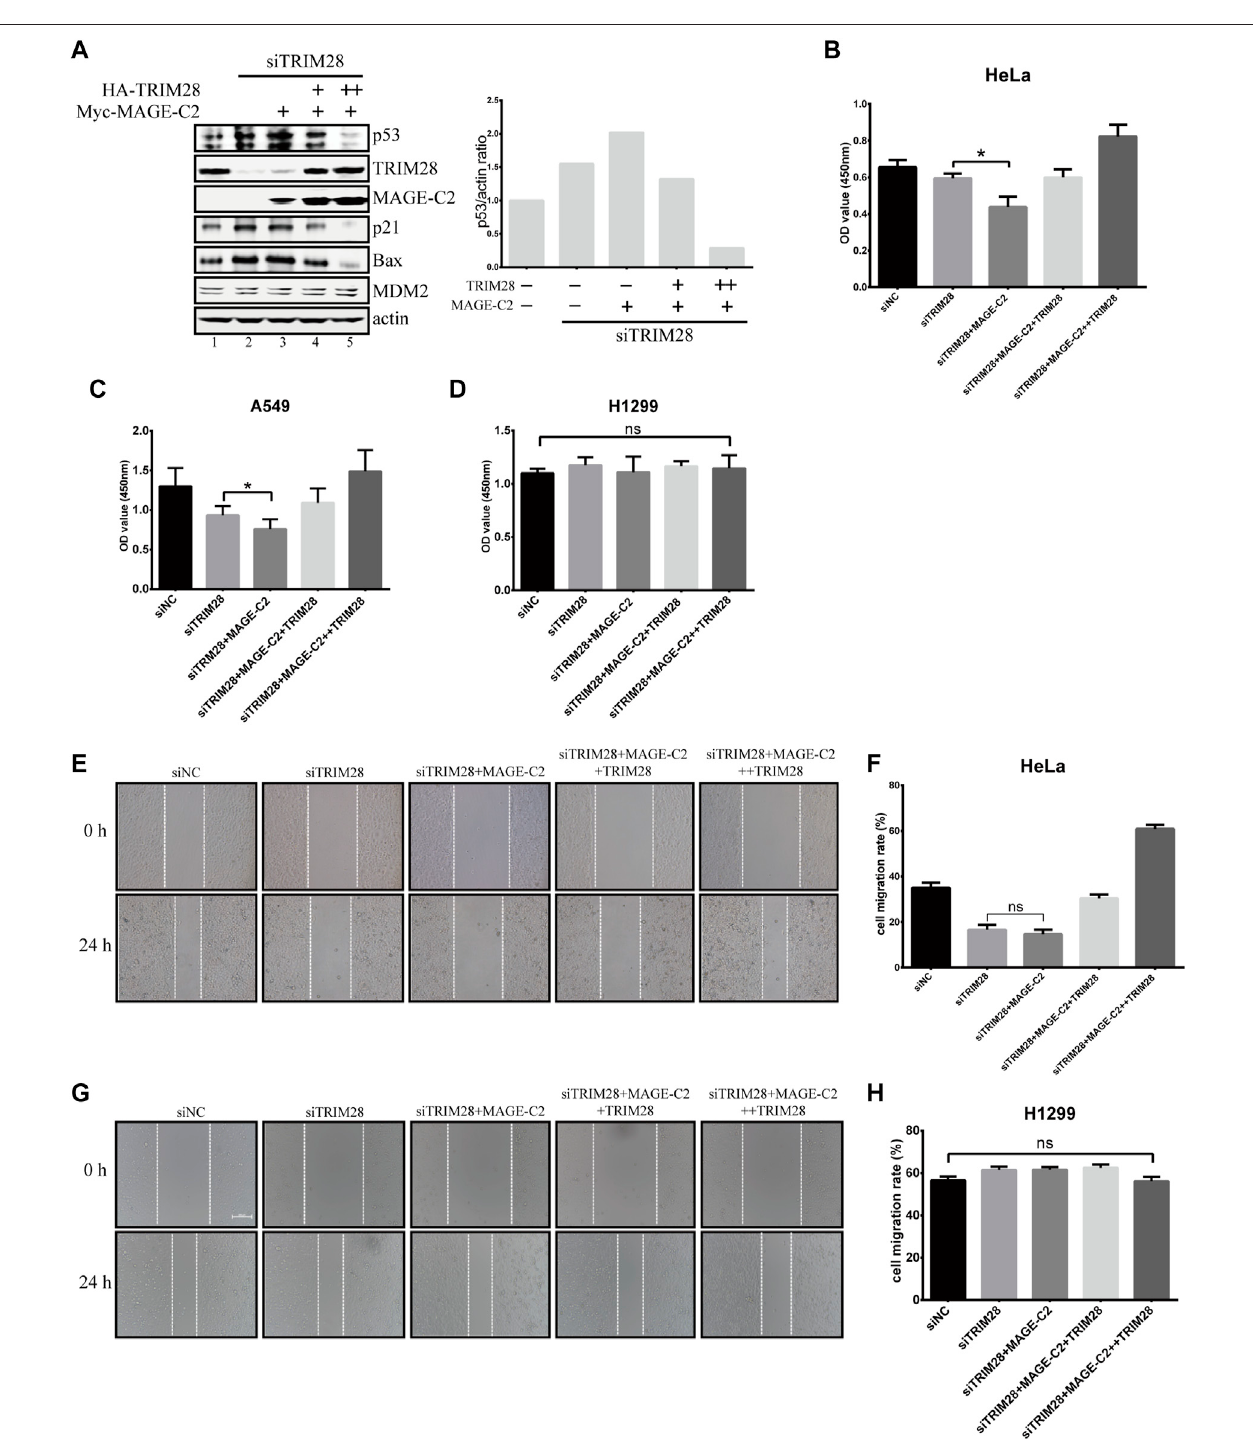
FIGURE5| TRIM28collaborateswithMAGE-C2andMDM2topromotecellproliferationandmigration. (A) TRIM28 – RNAiwasrescuedbyansiRNA-resistantHA- TRIM28. Cell lysates were collected 36 h after transfection and immunoblotted with the indicated antibodies. (B – D) CCK-8 assay was performed to evaluate the cell viability in HeLa cells (B) , A549 cells, (C) and H1299 cells (D) . Average and SD are shown here. * p < 0.05. ns denotes no signi fi cance. +: 0.5 μ g TRIM28, ++: 1 μ g TRIM28. (E , F) HeLa cells and (G , H) H1299 cells were observed and photographed with an inverted microscope. The reduction rate of wound within 24 h represents the migration rate of cells. Average and SD are shown here. ns denotes no signi fi cance. +: 0.5 μ g TRIM28, ++: 1 μ g TRIM28.